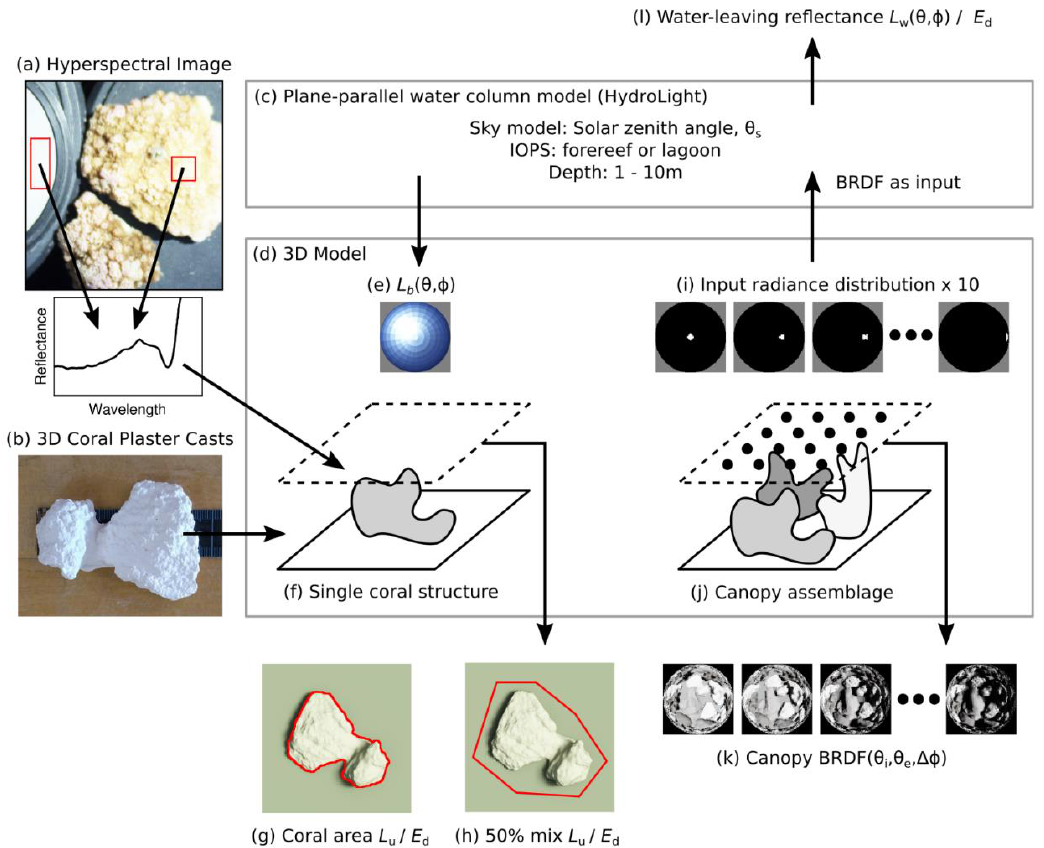
Figure 1. Model setup: ( a ) Coral surface reflectances were derived from hyperspectral image, and ( b ) shape from 3D reconstructions from plaster casts; ( c ) A plane parallel water column model was coupled with ( d ) a 3D canopy model in two ways: (1) ( e ) To model bottom of water column light fields over ( f ) single structures and estimate ( g ) reflectance over the coral and ( h ) of a 50% mix with surrounding substrate; and (2) ( i ) Directional incident radiance at different angles over ( j ) assemblages of structures were used to characterize ( k ) the bi-directional reflectance distribution function (BRDF). The BRDF was then input to the water column model to give ( l ) water-leaving reflectances.